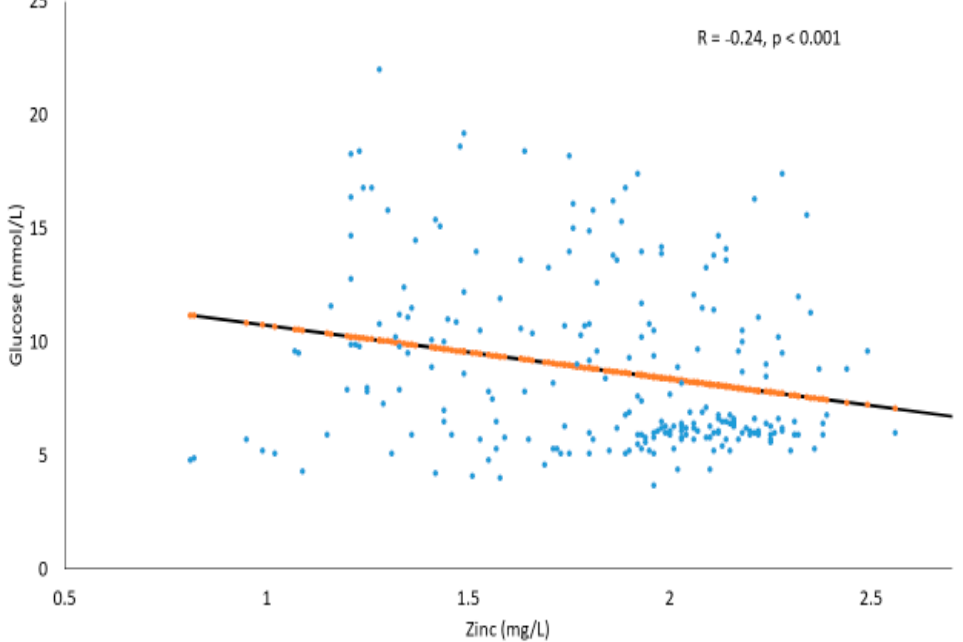
Figure 2. Correlation between glucose (mmol/L) and Fe (mg/L) in T2DM and prediabetes subjects.